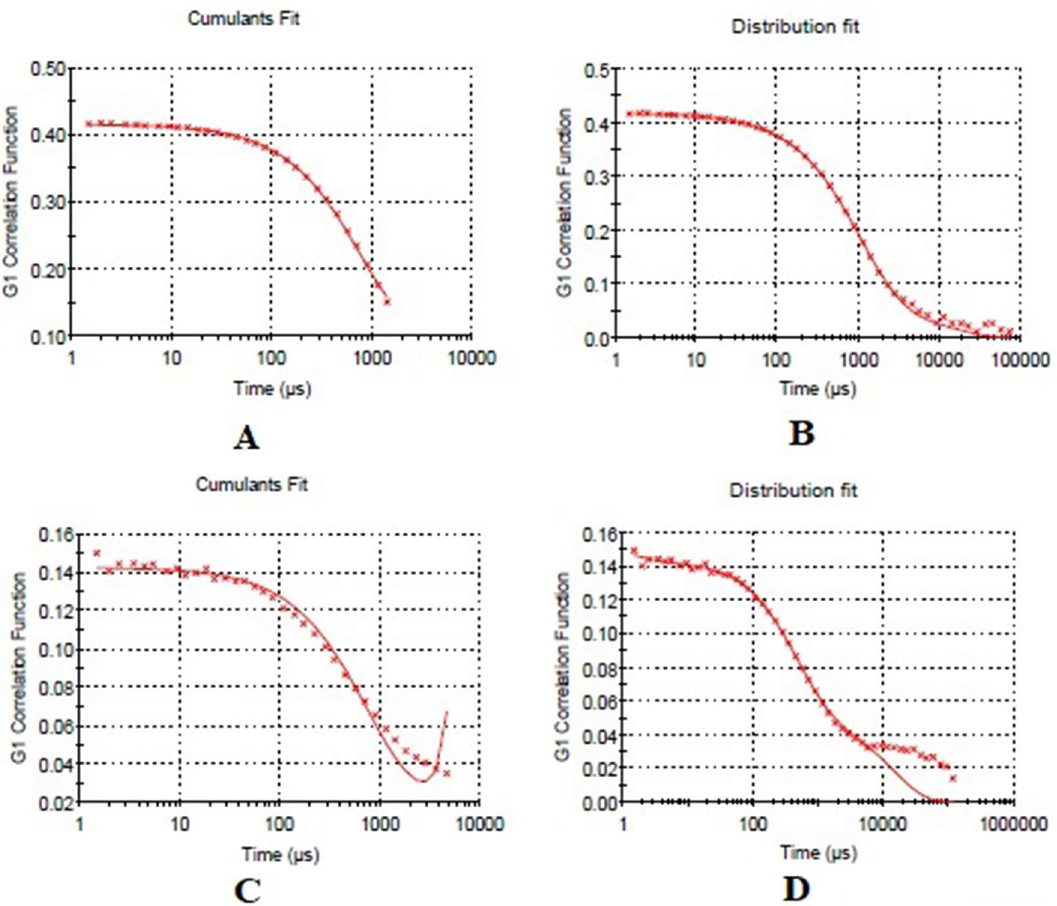
Figure 4. Physical characterization of nanoparticles. ( A ) Cumulative fit analysis of injectable CCNP colloidal solution. ( B ) Size distribution analysis of injectable CCNP colloidal solution. ( C ) Cumulative fit analysis of injectable mAbCCNP colloidal solution. ( D ) Size distribution analysis of injectable mAbCCNP colloidal